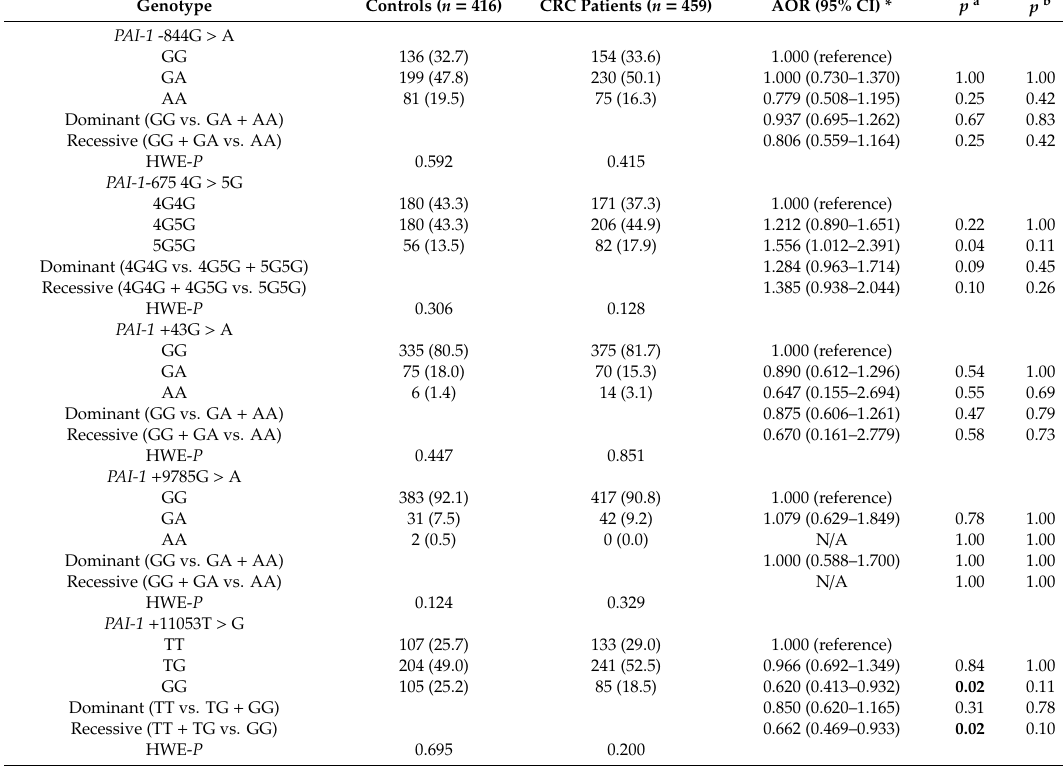
Table 2. Comparison of the genotype frequencies and AOR (adjusted odds ratio) values of PAI-1 gene polymorphisms between the colorectal cancer and control